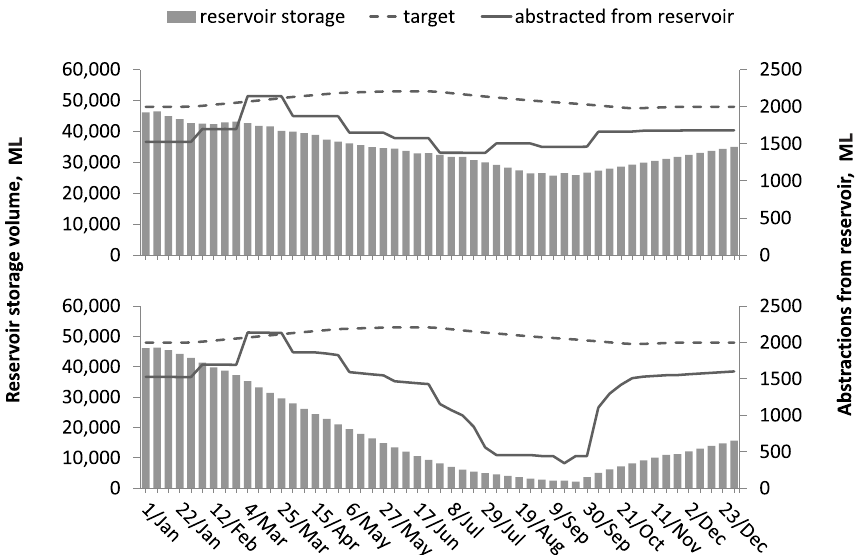
Figure 4. PWS reservoir storage and abstraction profiles for current (top panel) and proposed (bottom panel) licensing systems.